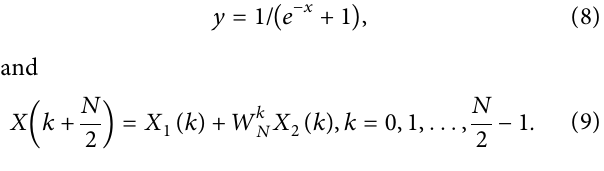
Figure 3: Client